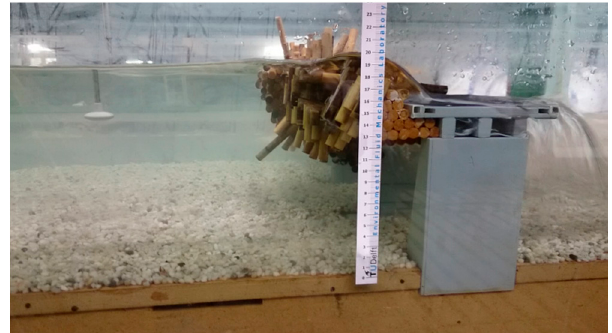
Figure 8. Laboratory setup showing the rigidly connected deck-pier system with excessive debris damming.